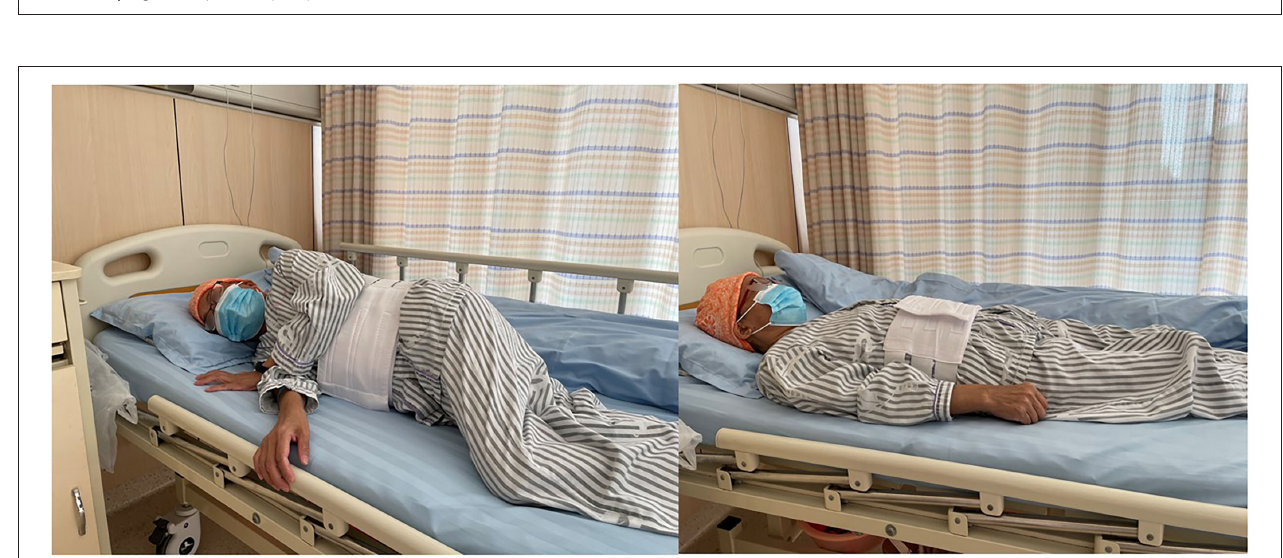
FIGURE 3 | The alternation between right-side and combined position (CRP): right lateral decubitus for 2h, followed by supine position for 1h.